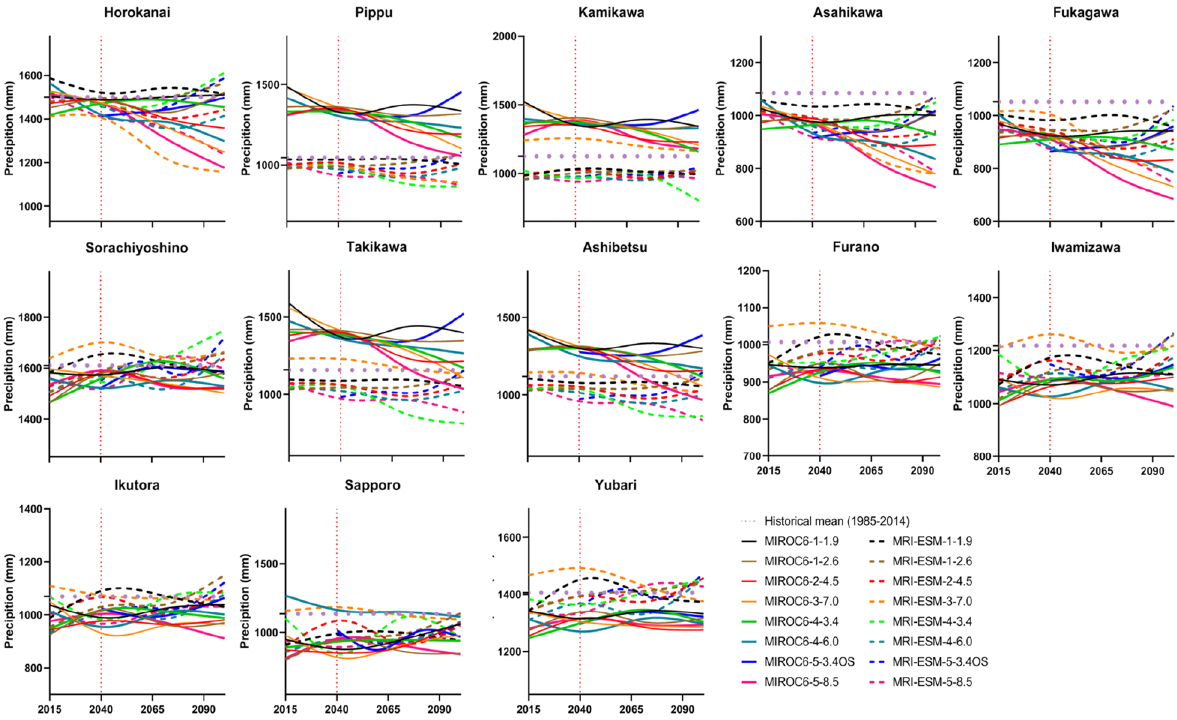
Figure 7. Annual mean precipitation under SSP-RCPs scenarios of two